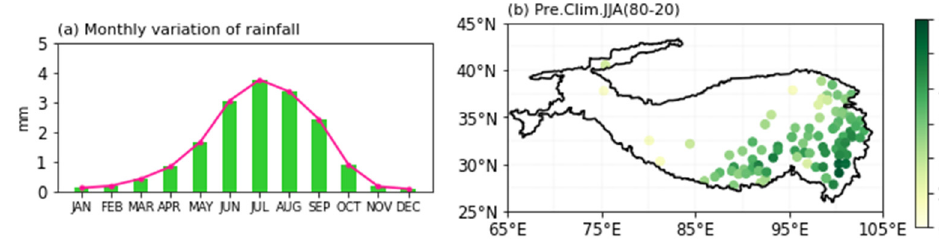
Figure 1. ( a ) Monthly variation in total rainfall and ( b ) spatial pattern of climatological summer (JJA) precipitation over TP during 1980–2020.